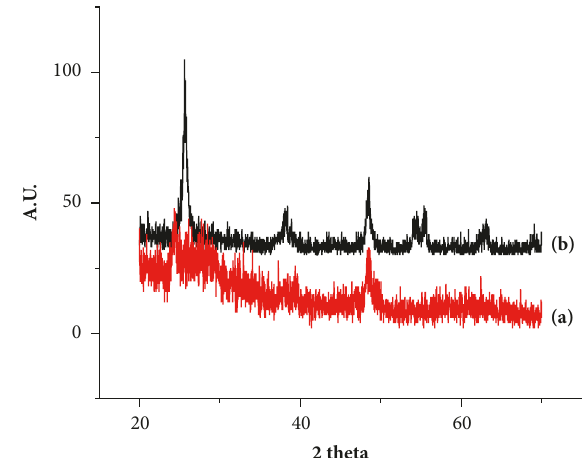
Figure 2: XRD spectra of hydrothermally synthesized powder (a) before and (b) after heating at 400 ∘